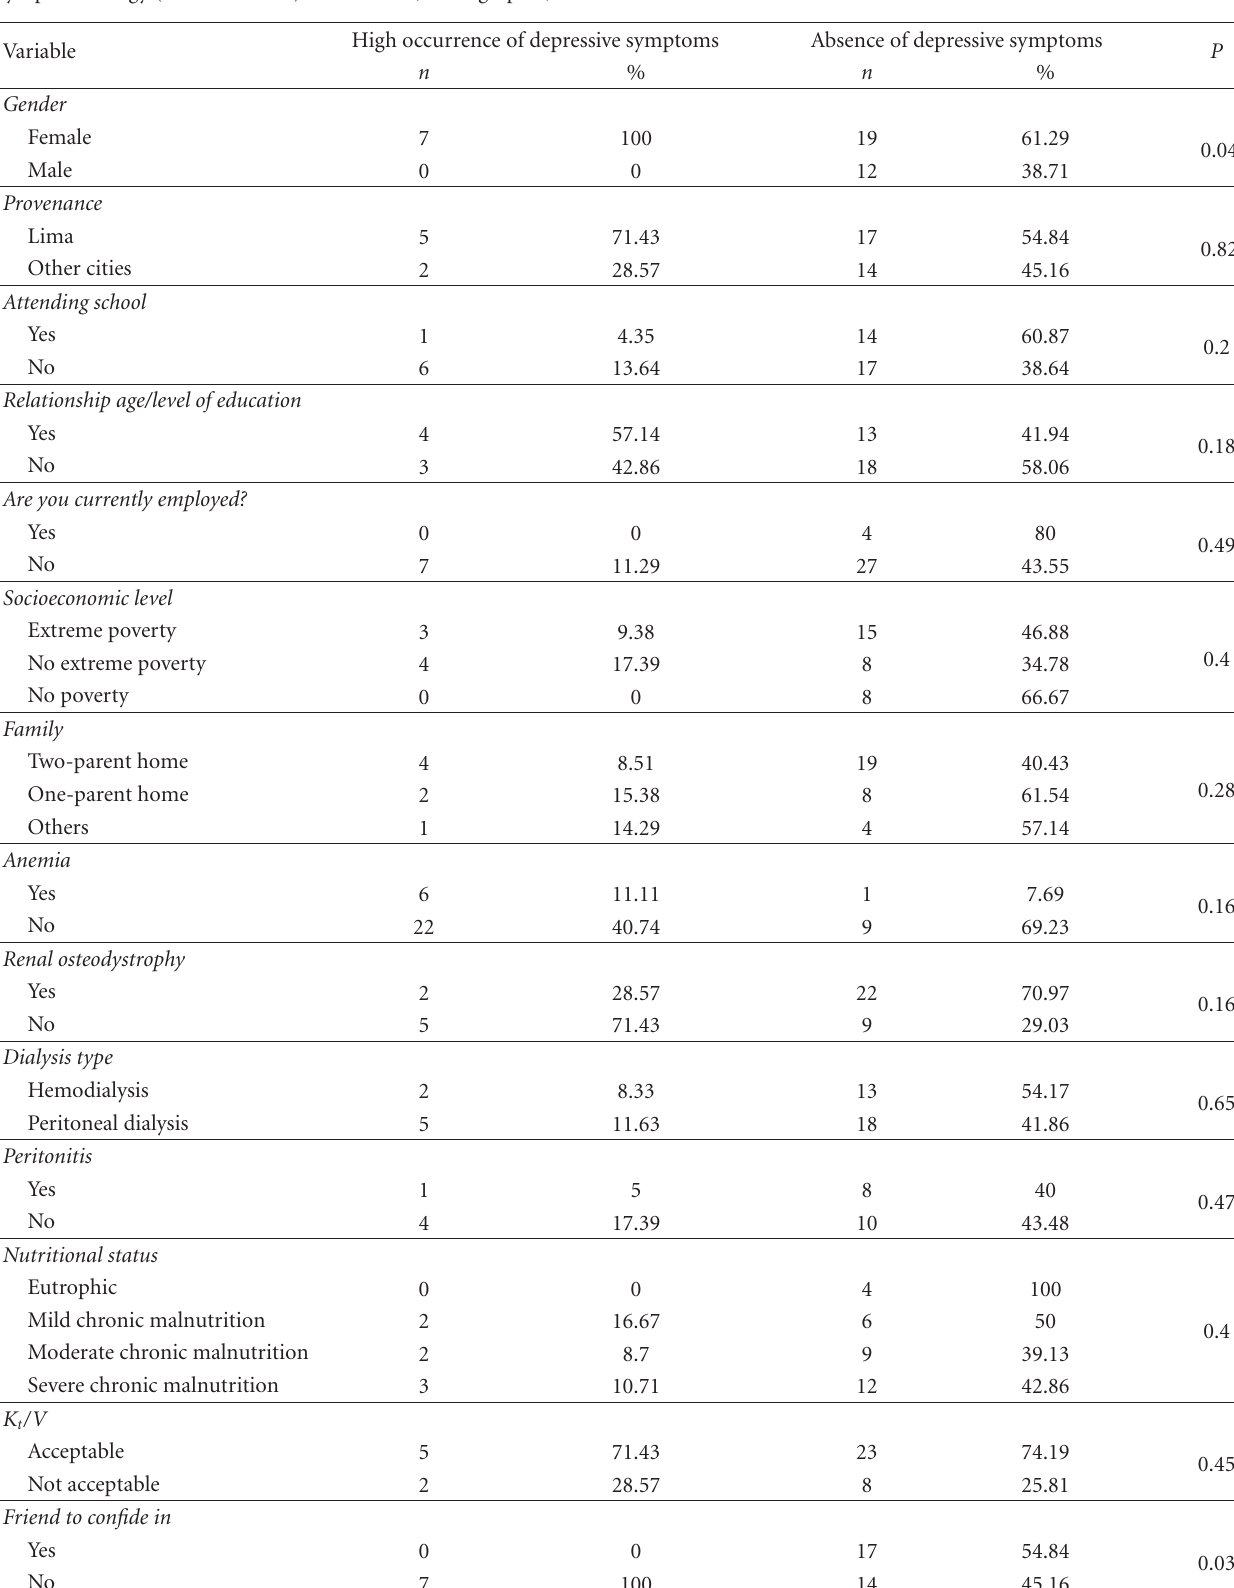
Table 1: Correlation of high occurrence of depressive symptoms (score above 21 according to Birleson Scale) and absence of depressive symptomatology (score below 13) with clinical, demographic, and social